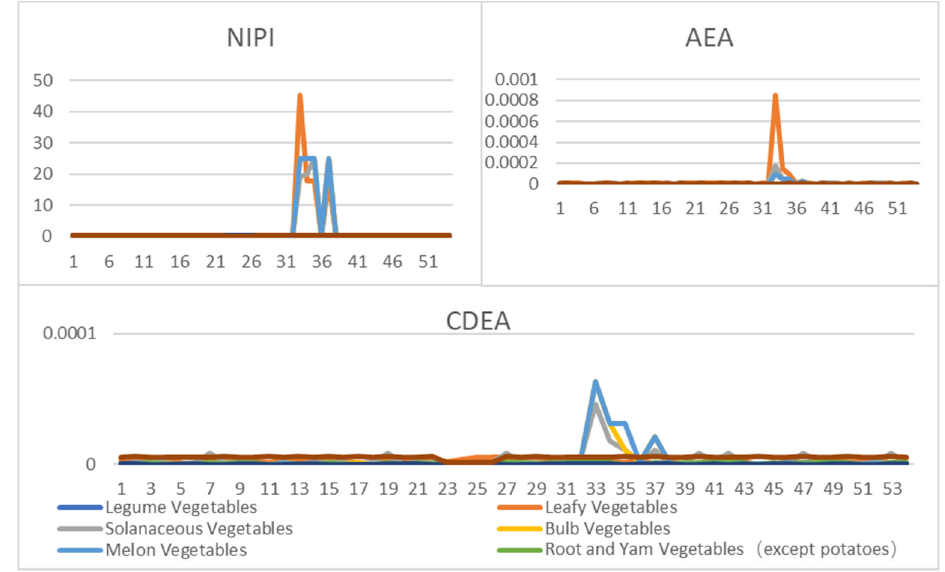
Figure 3. Food security risk assessment indexes of eight kinds of vegetables per week in Beijing from January to December.